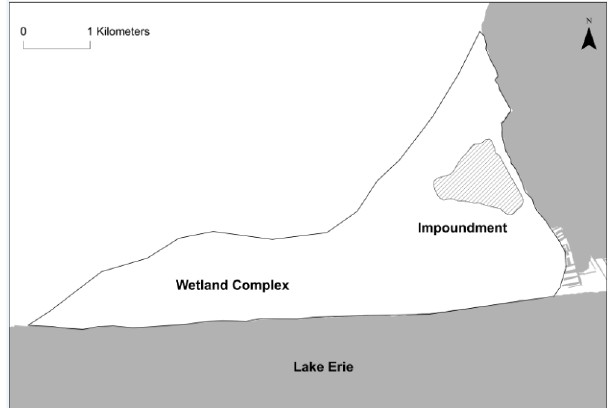
Figure 1: Our study took place in an impoundment (stipled) along the northern shore of Lake